Question: Summarize what this figure shows in one sentence.
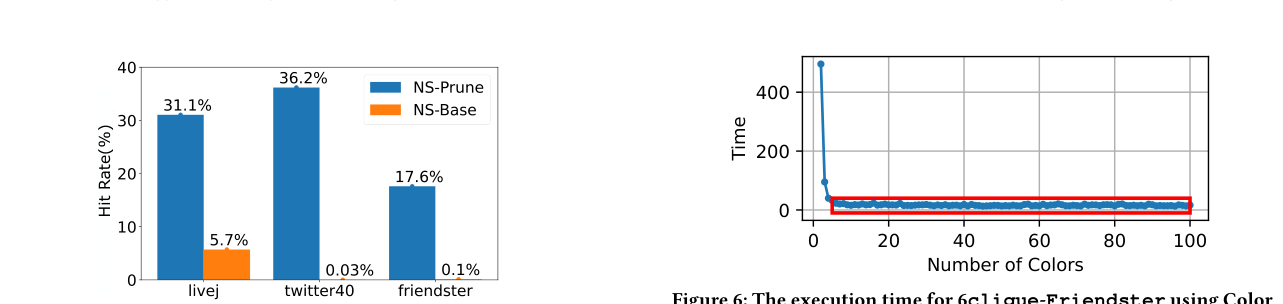
Answer: Comparing the hit rate of NS-prune with NS-base, with the 4-clique pattern on various graphs.